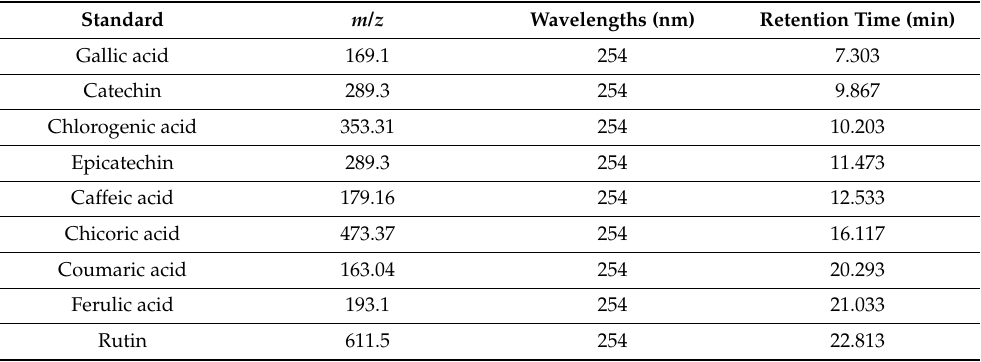
Table 6. Wavelengths of quantification and retention times related to the investigated phenolic com-